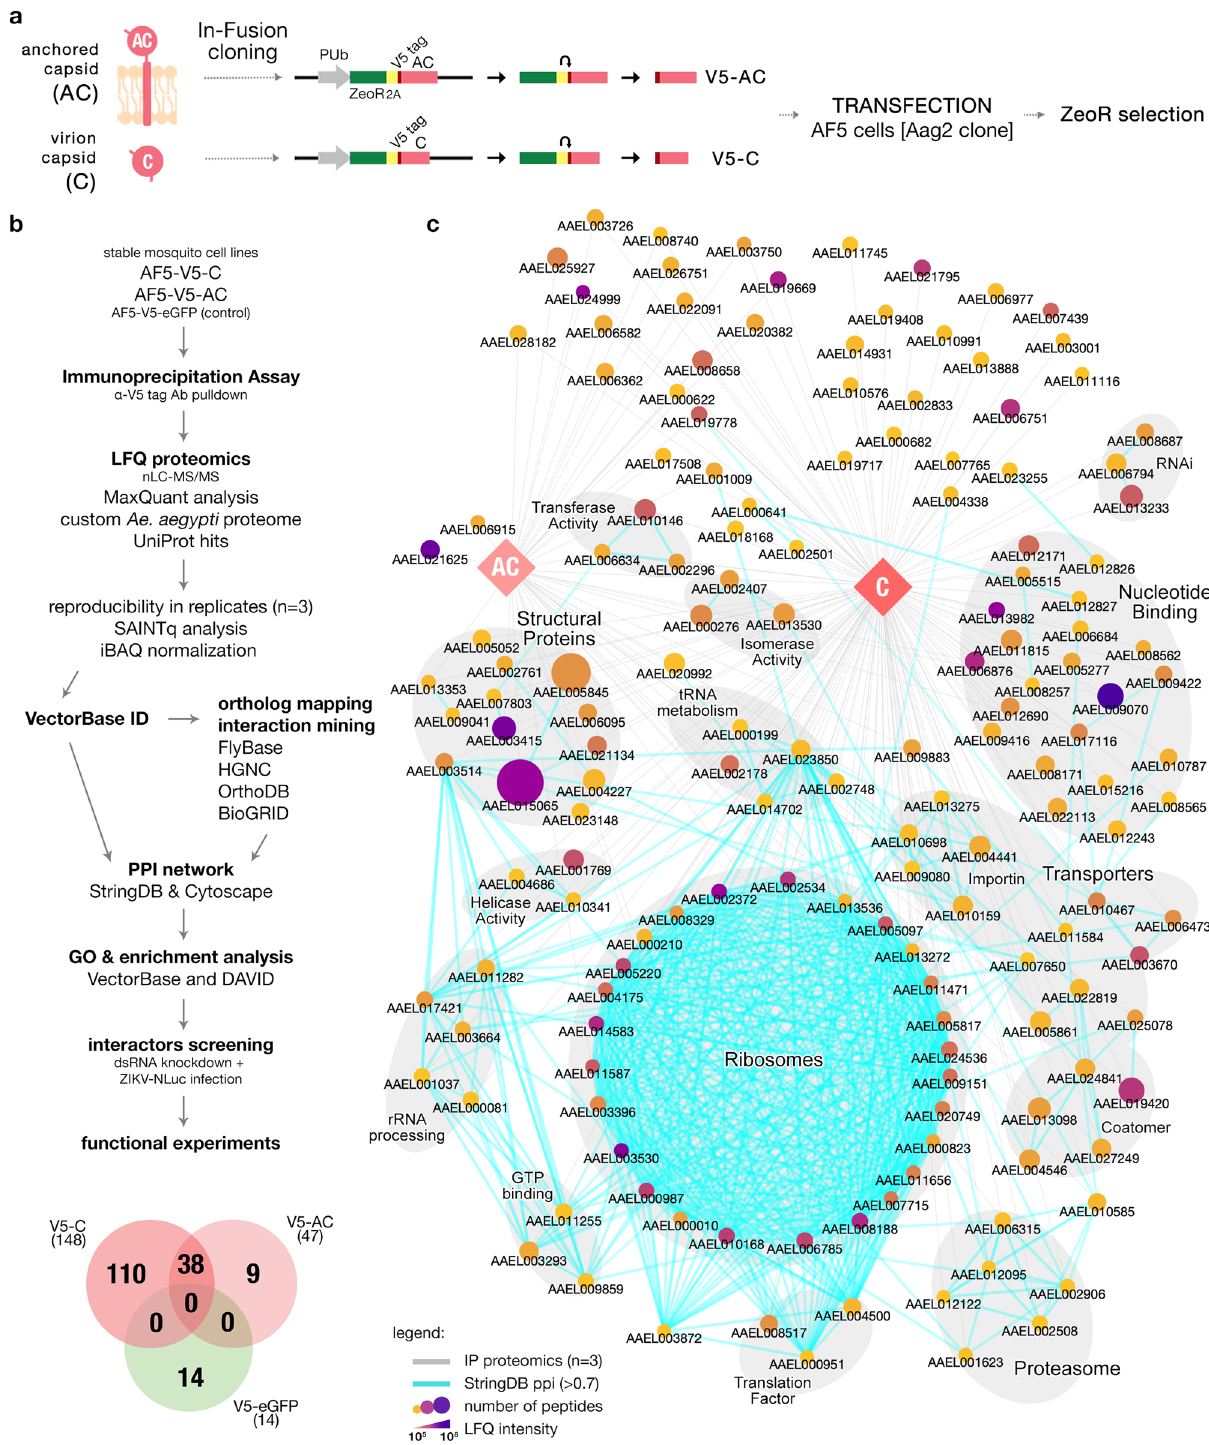
Fig. 1 Developing Ae. aegypti Stable Mosquito Cell Lines for Studying ZIKV C and AC PPI. a Schematic showing plasmid constructs used to express V5- tagged ZIKV C or AC under the control of a PUb promoter with ZeoR gene, and duplicated 2A autocleavage sequence. b Study pipeline using developed Ae. aegypti -derived AF5 cell line stably expressing ZIKV C or AC to investigate vector-virus PPIs. Venn diagram showing the distribution of potential interactors among immunoprecipitated proteins. c ZIKV capsid- Ae. aegypti PPI network of 157 interactors from IP proteomics. C and AC nodes (diamonds) with IP proteomics interaction (gray edges) to host interactors (circles) and StringDB PPI (cyan edges). Gray highlights enclose nodes with broadly related functions. List of protein interactors provided in Supplementary Tables 1 and